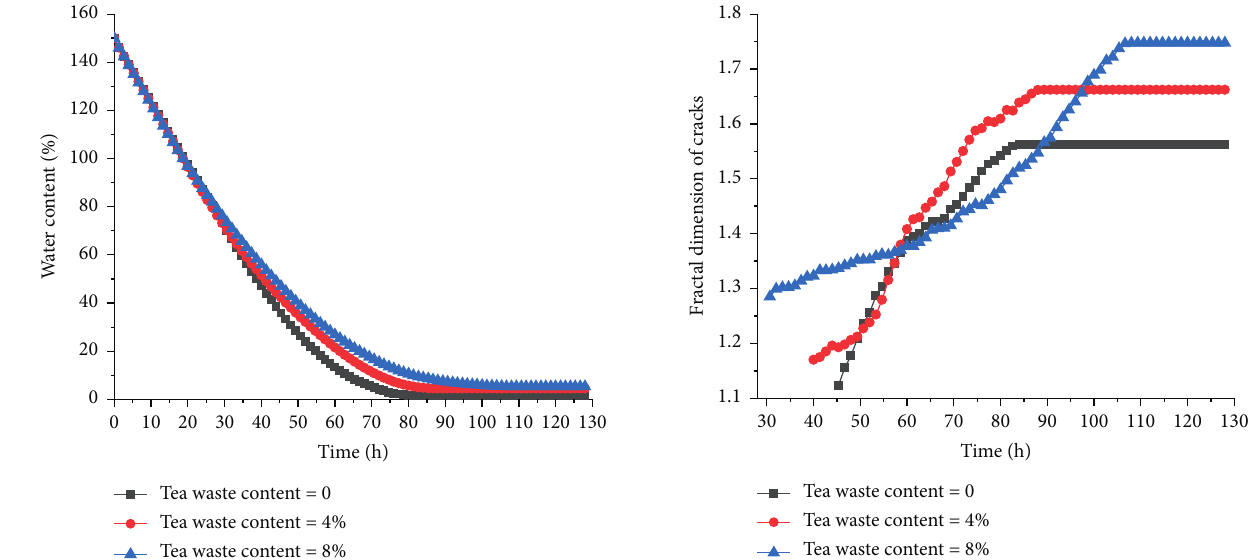
Figure 3: The water content versus different tea waste contents of samples.